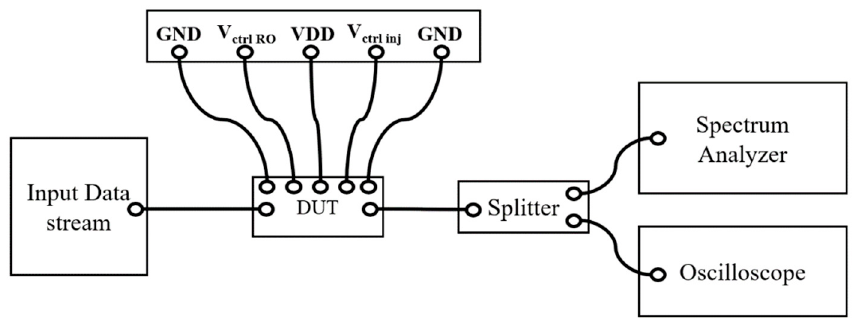
Figure 8. Schematic of the test bench. V ctrl RO allows for precise locking to the target frequency whereas V ctrl inj controls the injection signal strength sent into the ring